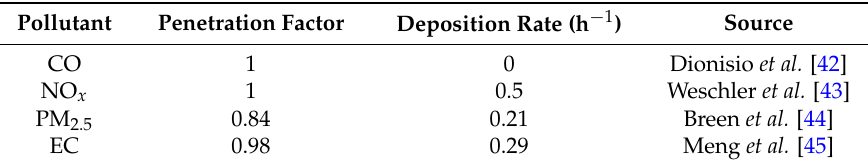
Table 2. Penetration factor P and deposition rate k d